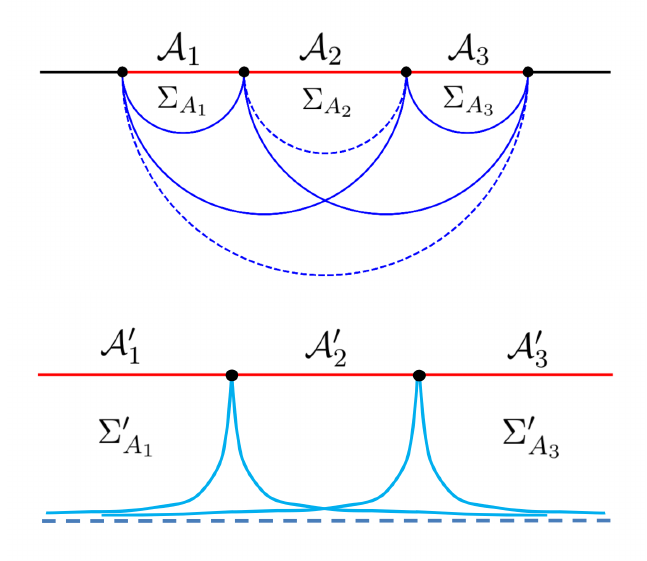
Figure 6: The upper figure shows the RT curves (solid blue curves) for the subregions in the linear combination in the ALC proposal . The lower figure shows the images of the above RT curves in the Rindler spacetime. Since A (cid:48) all infinite half lines, their RT surfaces are the same up to a translation or